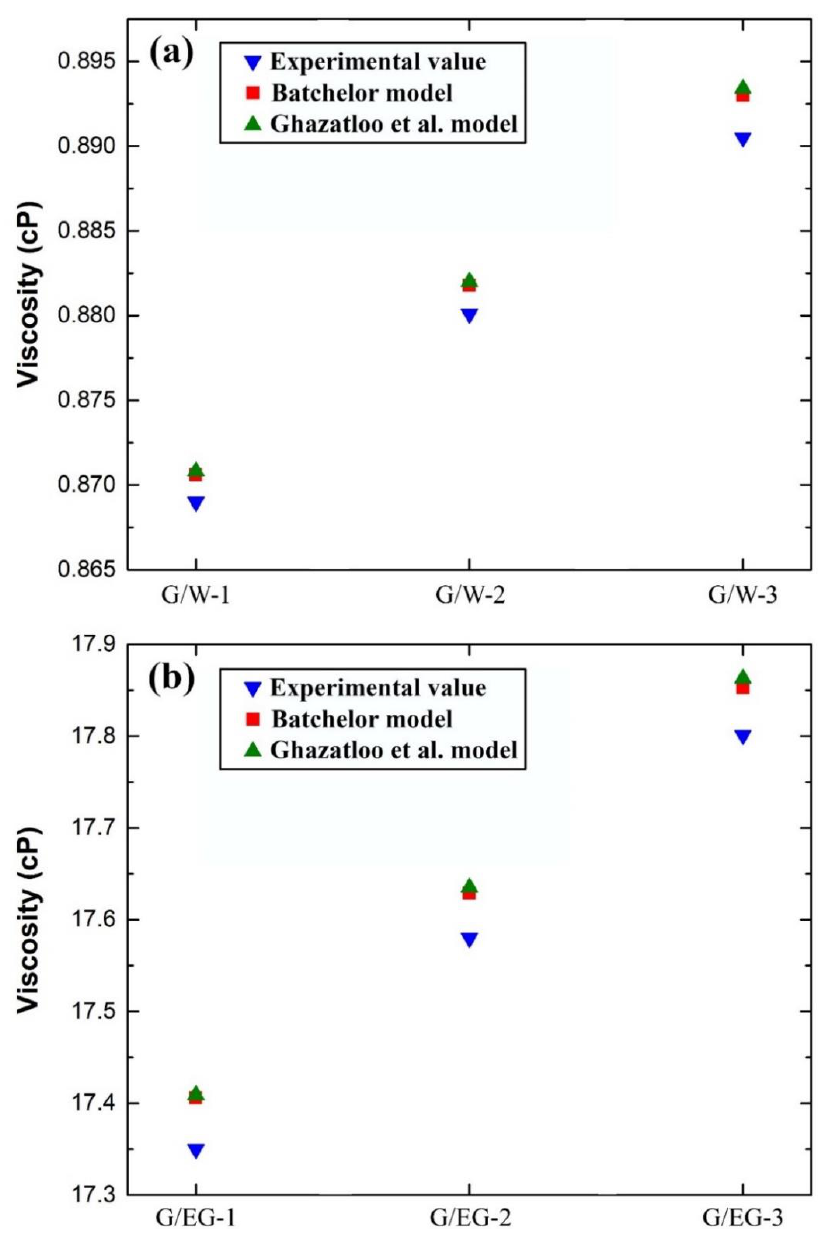
Figure 18. Comparison between the Ghazatloo et al. [269] model, Batchelor [270] model, and experimental effective viscosity, where ( a ) shows the results for graphene – water nanofluid of 0.5 vol. % (G/W-1), 1.0 vol. % (G/W-2), and 1.5 vol. % (G/W-3), and ( b ) illustrates the values for graphene – EG suspensions of 0.5 vol. % (G/EG-1), 1.0 vol. % (G/EG-2), and 1.5 vol. % (G/EG-3).